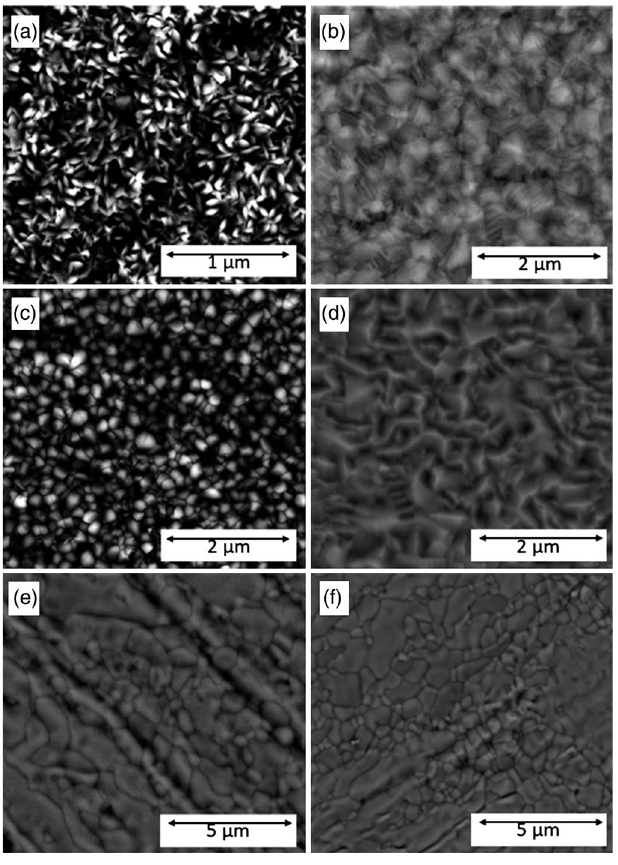
FIG. 13. Planar SEM images of niobium thin film samples deposited (a) at room temperature and no bias, (b) at room temperature with − 80 V bias, (c) at 500 °C with no bias, (d) at 500 °C and − 80 V bias, (e) at 700 °C with no bias and (f) at 700 °C with − 80 V